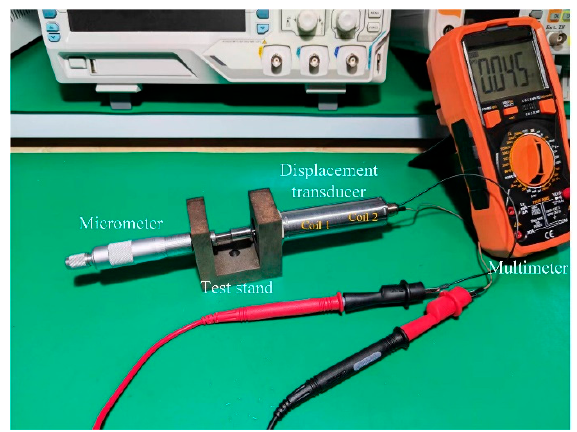
Figure 11. Testing of the resistance and inductance of DIPT16.